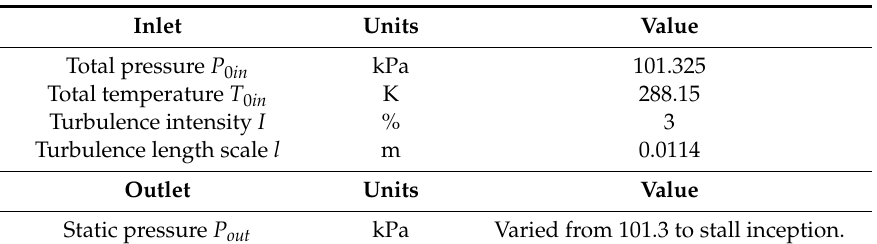
Table 2. Flow conditions used for the numerical